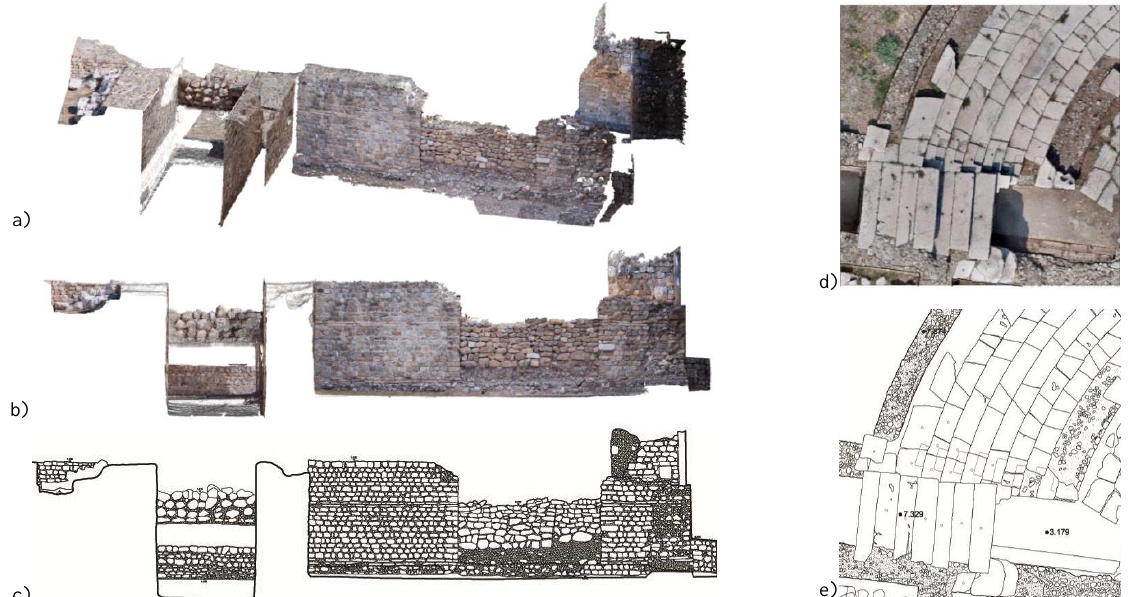
Figure 7. Digitalization of section FF’ shown in Figure 1a: Point cloud from terrestrial photogrammetry (a), ortho image (b) and CAD section (c). A particular of the orthoimage from aerial imagery (d) and the produced CAD drawing